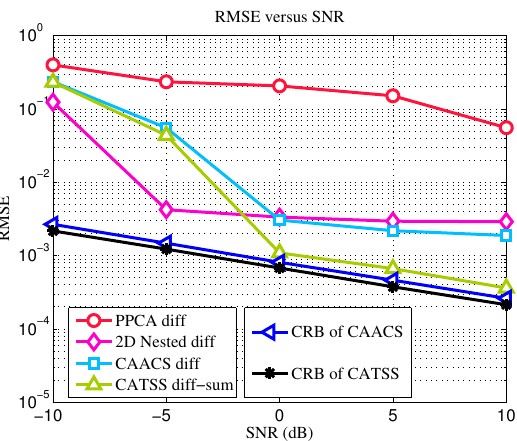
Figure 11. RMSE as a function of SNR for different array configurations with M 1 = 9, M 2 = 5, p = 3, l = 32. The number of snapshots is K = 200, and the pseudo snapshots satisfy K p = K .